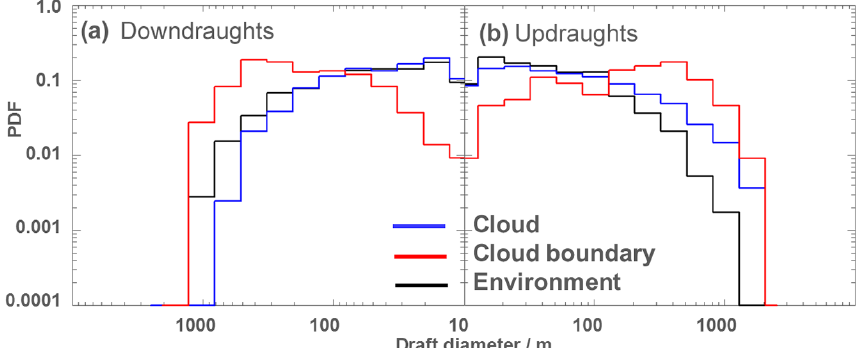
Figure 11. Probability density functions (PDFs) of the diameters of the updraughts and downdraughts. The distributions are shown separately for the draughts inside of the cloud, at the cloud boundaries and the near